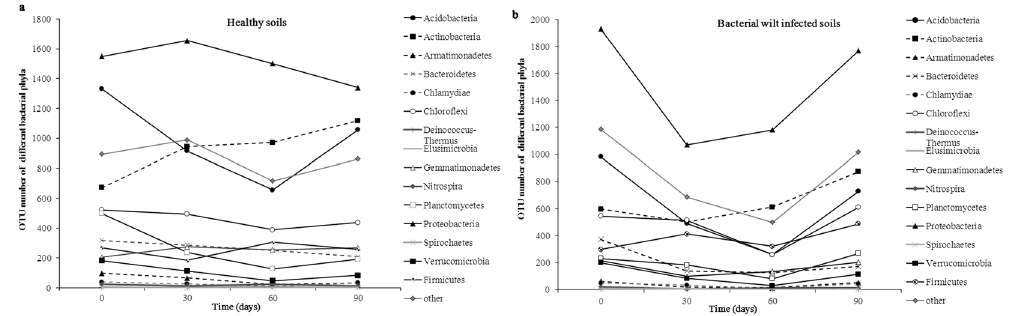
Figure 1. Temporal trends of different bacterial phyla in healthy soils ( a ) and bacterial wilt infected soils ( b ) during the different tobacco growth